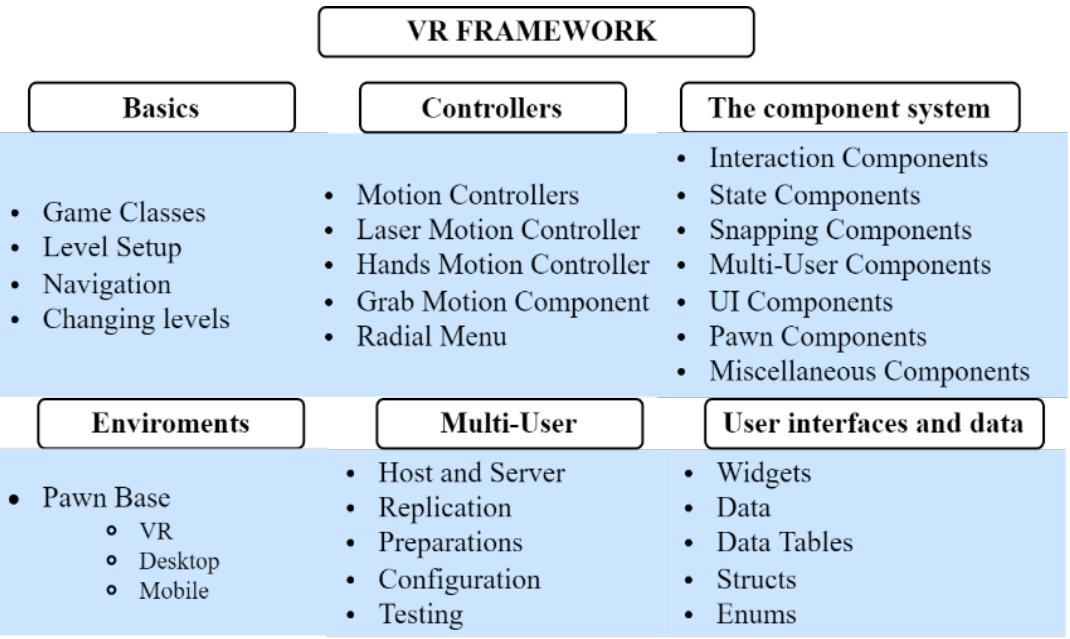
Figure 1. The unreal engine experiment framework.